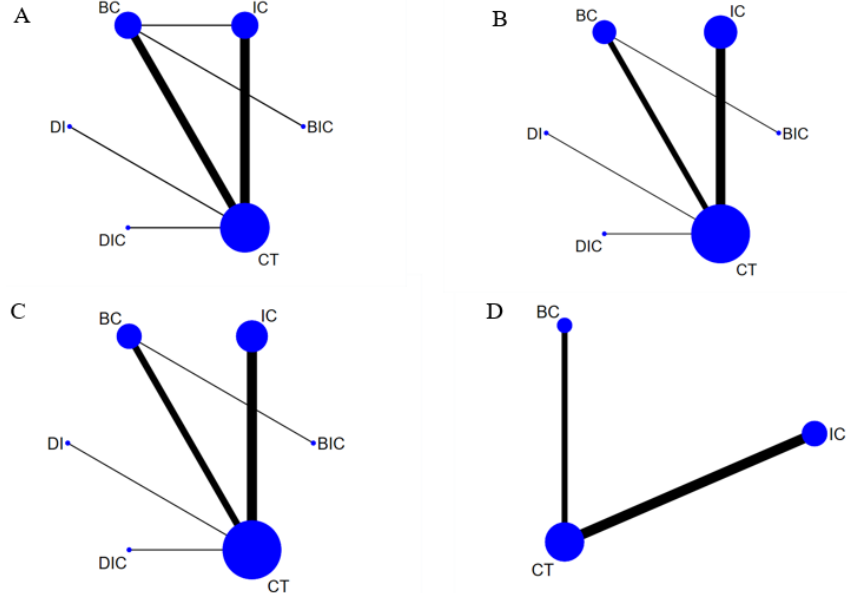
Figure 2. Network plot of OS ( A ), PFS ( B ), ORR ( C ) and ≥ 3 TRAEs ( D ). Each circular node represents a treatment type. The circle size is proportional to the total number of patients. The width of the line is proportional to the number of studies performing head-to-head comparisons in the same study, and the dotted line is the indirect comparison which was shown in this network meta-analysis.